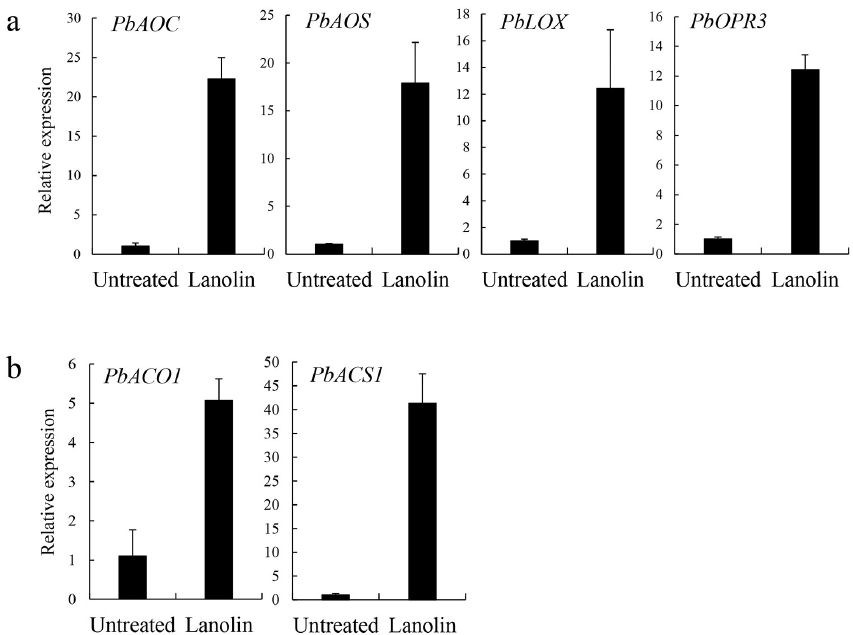
Figure 3. The expression analysis of jasmonate- and ethylene synthesis-related genes. The expression levels of ( a ) jasmonate and ( b ) ethylene synthetic genes in lanolin-treated and untreated control ‘Zaosu’ pear fruit after 10 days of treatment. Data are means ± SDs of three biological replicates.